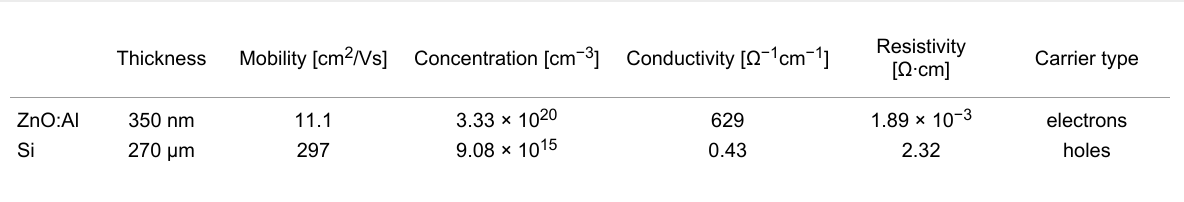
Table 2: Electrical parameters of investigated PV structures grown on p Si